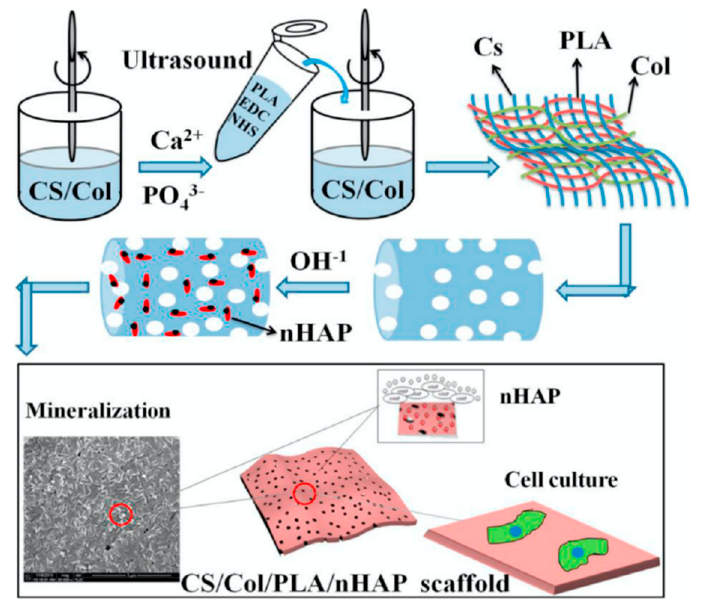
Figure 12. Schematic formation of the CS/Col/PLA/nHAP hybrid scaffold [197]. Reprinted with permis- sion from ref. [194]. 2019 Elsevier